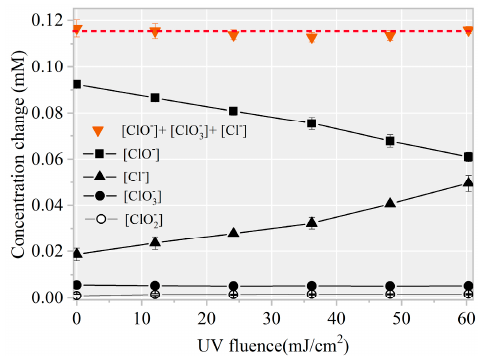
Figure 4. Mass balance of chlorine element during AHTN degradation by UV/FC ([AHTN] 0 = 1.0 mg · L − 1 ; [FC] 0 = 3.28 mg · L − 1 ; pH = 7.0; and 25 ± 1 °C).